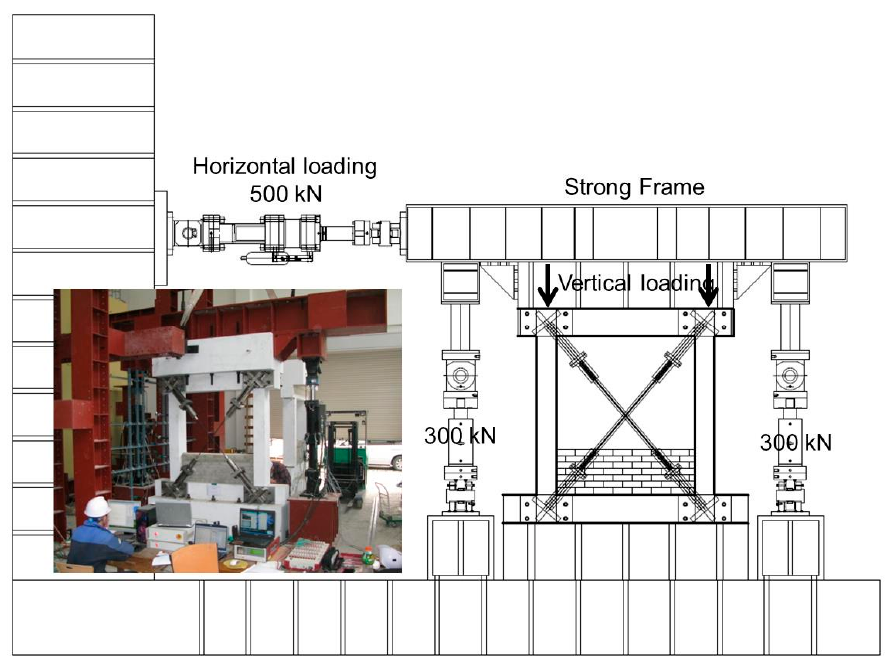
Figure 5. Experimental configuration for the cyclic loading tests.